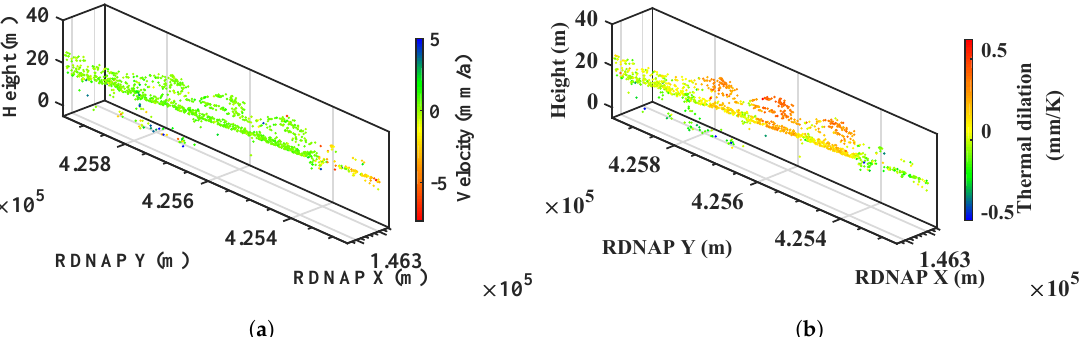
Figure 13. Parameters of the selected bridge: ( a ) velocity map, showing the transitions of velocity between bridge and ground; and ( b ) thermal dilation map, showing the strong thermal dilation on the bridge structure.